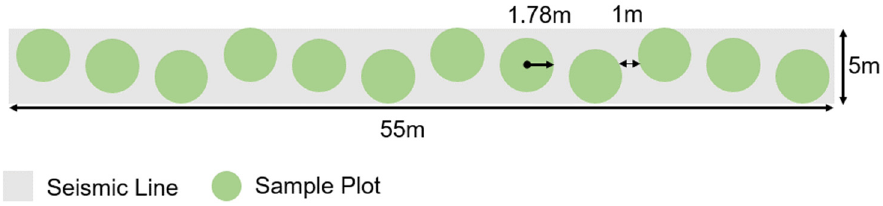
Figure A2. Layout of the circular sampling plots used to measure woody vegetation on seismic lines. LiDAR data were collected by walking the perimeter of the 55 m long area.